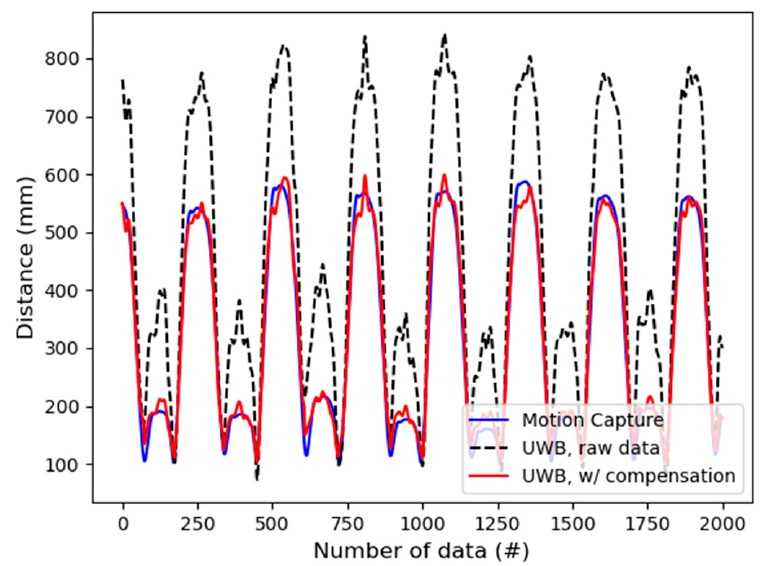
Figure 5. Comparison of the UWB data with motion capture system data. Black-do tt ed line: UWB raw data with the Savi tz ky–Golay fi lter, blue-solid line: data obtained using motion capture system, red-solid line: UWB data o ff set compensated using SVR.